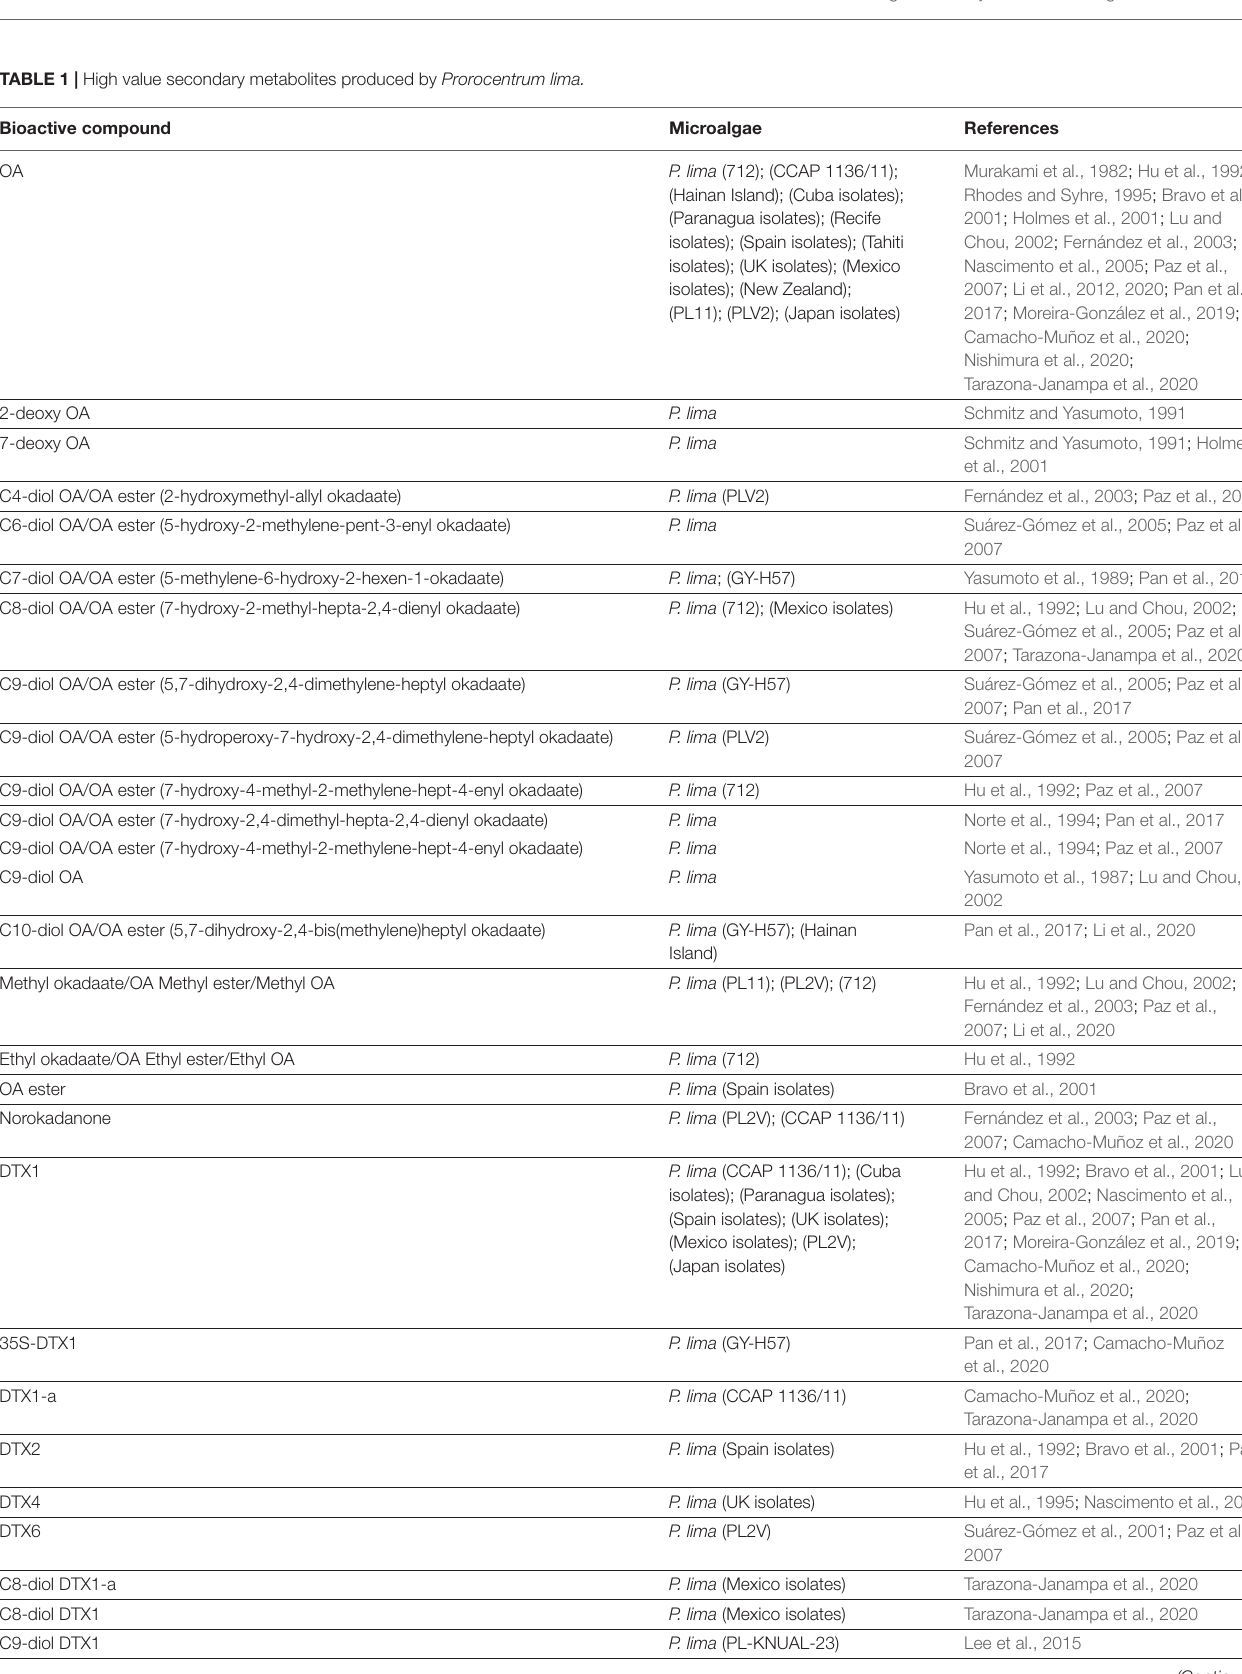
TABLE 1 | High value secondary metabolites produced by Prorocentrum